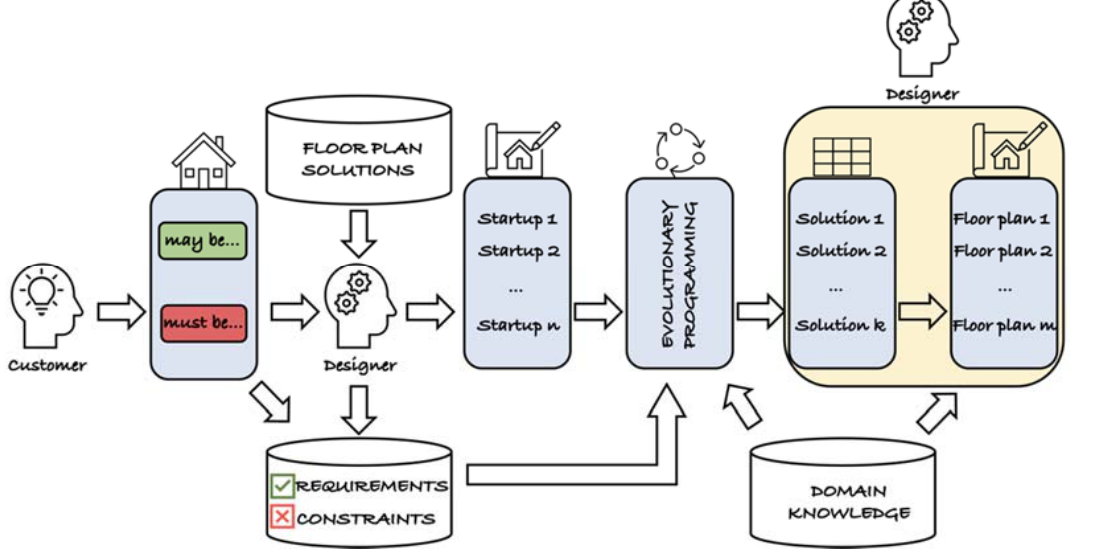
Figure 1. Visual Floor Plan Generation (VFPG) framework.